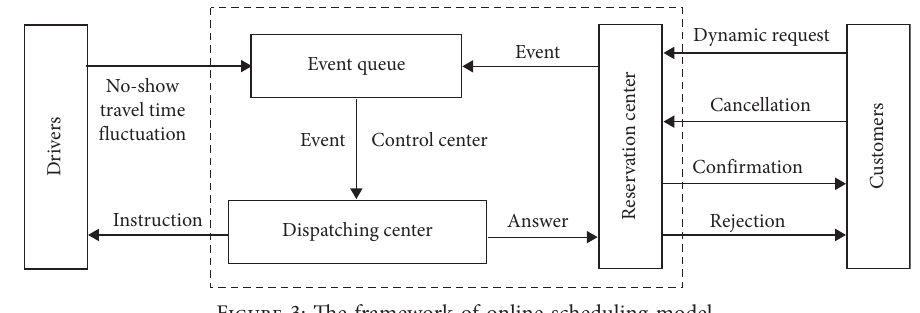
Figure 3: The framework of online scheduling